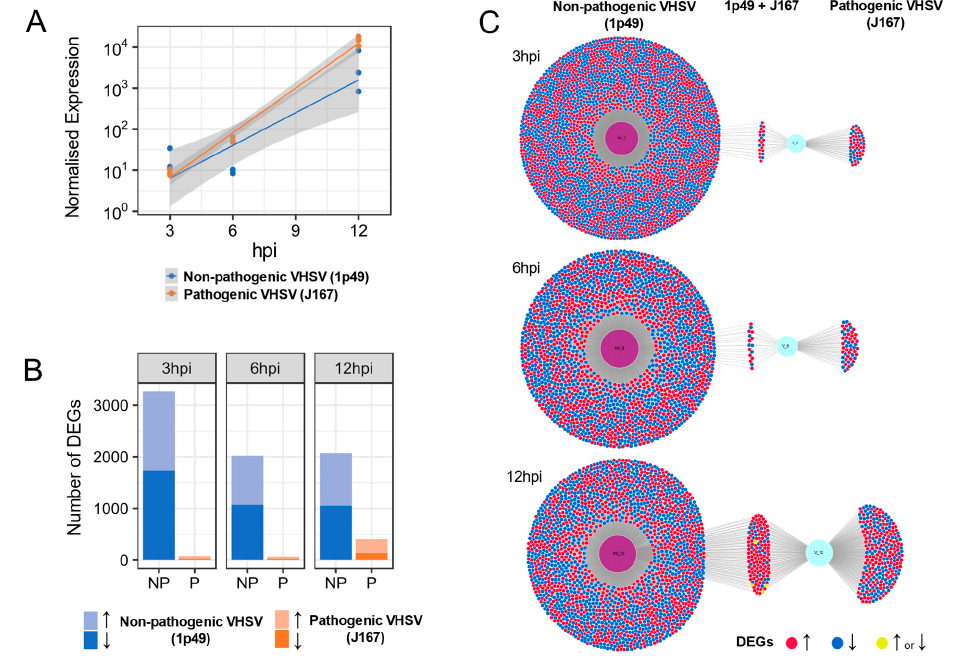
Figure 1. Gene expression of the rainbow trout gonad cell line RTG-2 inoculated either with a non-pathogenic (1p49; NP) or a pathogenic (J167; P) viral haemorrhagic septicaemia virus (VHSV) isolate. ( A ). Normalised viral sequence reads at 3, 6, and 12 h post-inoculation (hpi). ( B ) Number of differentially expressed genes (DEGs) in RTG-2 cells over time inoculated either with the non-pathogenic or pathogenic isolates. Arrows indicate whether the genes were up-regulated or down-regulated. ( C ) Graphical overview of the number of differentially expressed host transcripts in cells inoculated with each viral isolate and a representation of overlapping host transcripts differentially expressed following inoculation with each isolate.